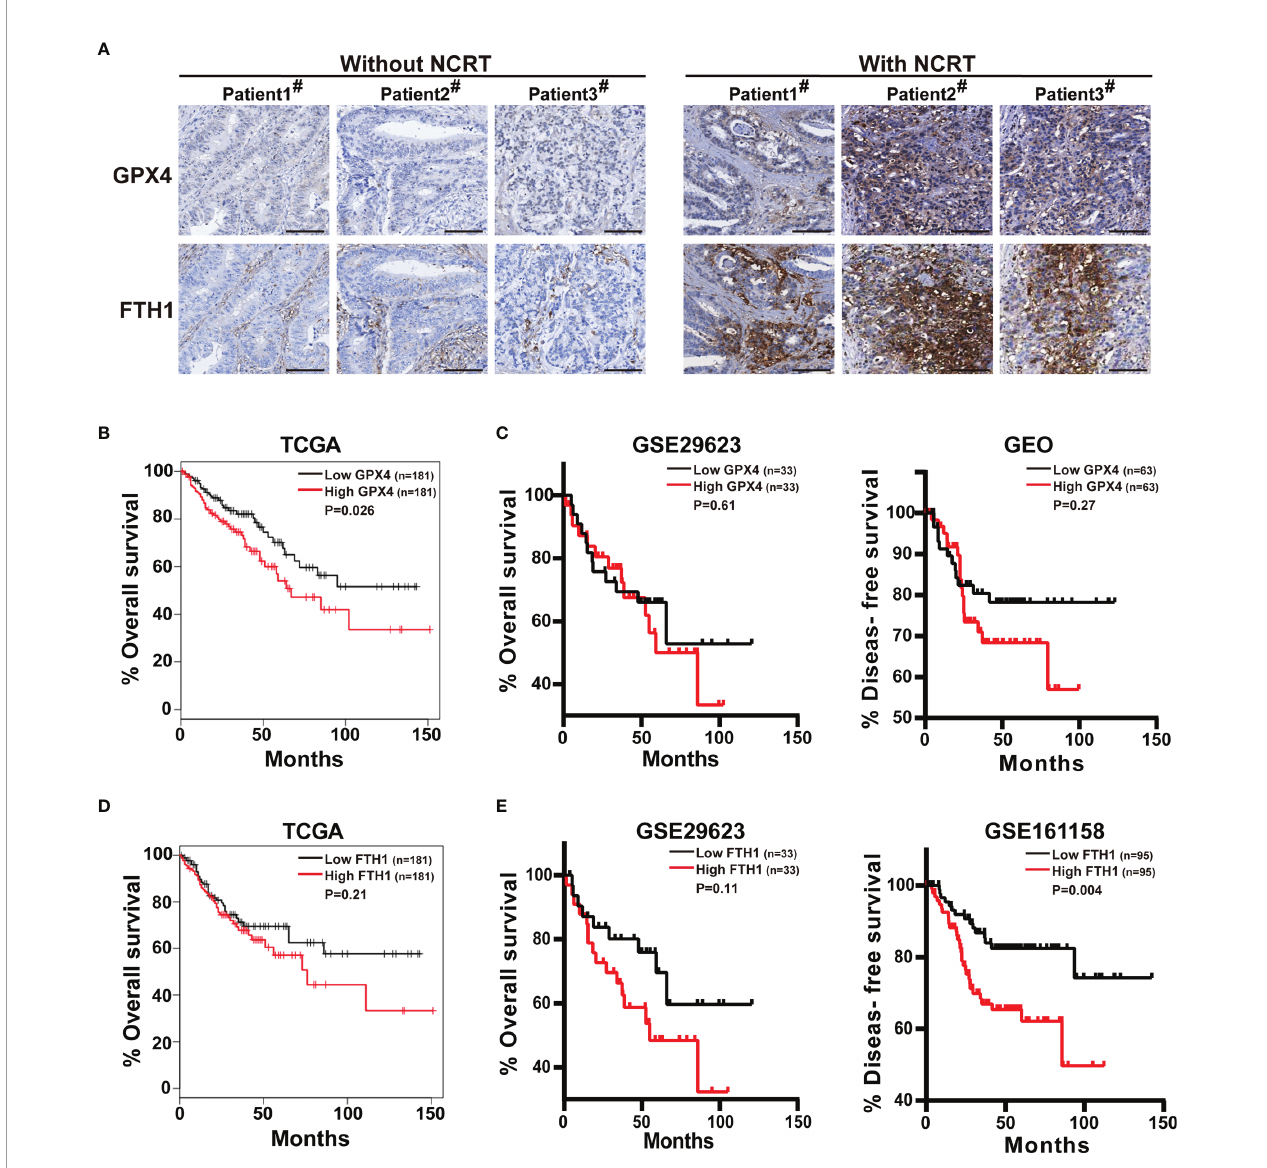
FIGURE 6 | GPX4 expression is upregulated in colorectal cancer patients undergoing neoadjuvant chemoradiotherapy and correlates with poor prognosis for patients. (A) GPX4 and FTH1 of biopsies from three colorectal cancer patients with neoadjuvant chemoradiotherapy and three patients without were measured by immunohistochemistry staining (scale: 100 m m). (B) Kaplan-Meier curves for overall survival of CRC patients with high vs. low GPX4 expression, according to the TCGA database. (C) Kaplan-Meier curves for overall and disease-free survival of CRC patients with high vs. low GPX4 expression, according to the GEO databases. (D) Kaplan-Meier curves for overall survival of CRC patients with high vs. low FTH1 expression, according to the TCGA database. (E) Kaplan-Meier curves for overall and disease-free survival of CRC patients with high vs. low FTH1 expression levels, according to the GEO